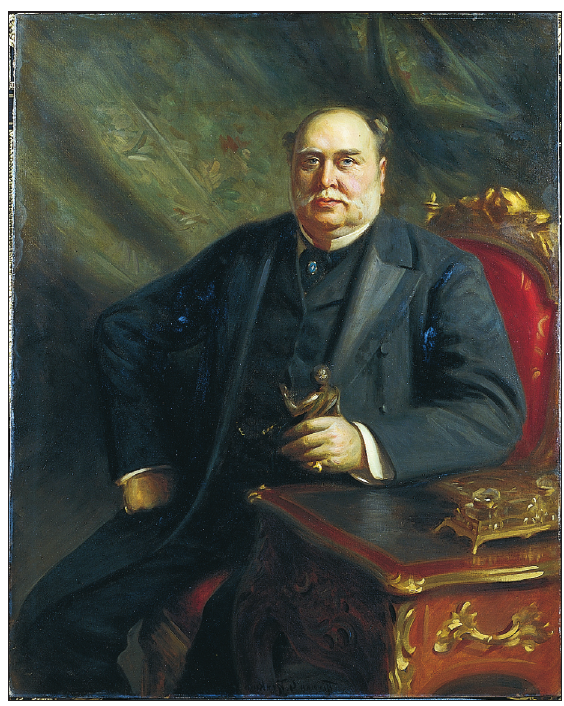
Fig. 12 : Herman G. Herkomer, Sir John Murray Scott , 190[9], oil on canvas, 127 × 101.6 cm, Hertford House Historic Collection, 2006.8. © The Trustees of the Wallace Collection,